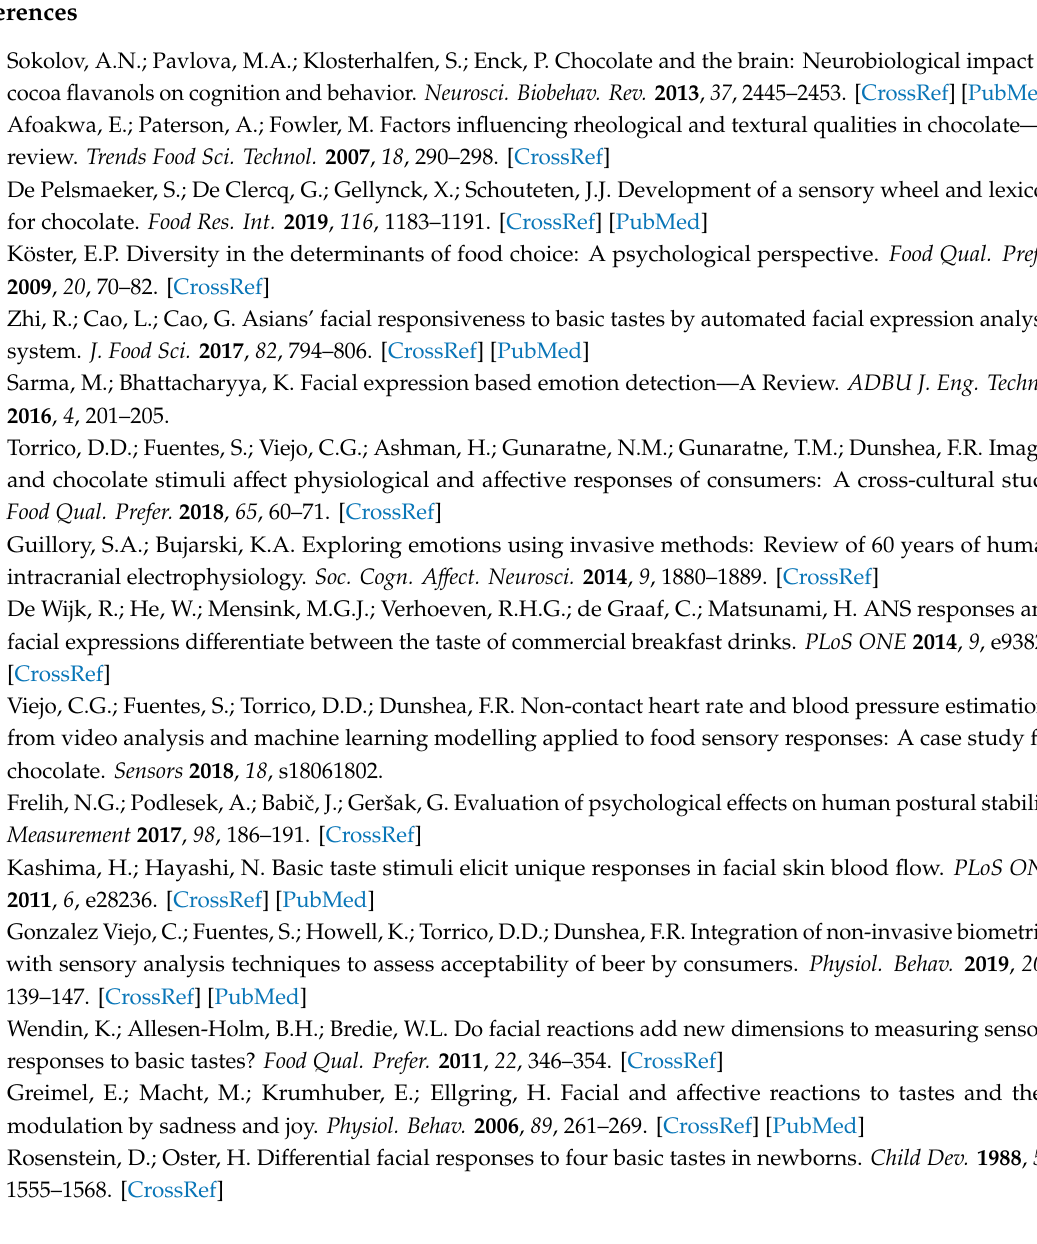
Table S1: Factor loadings from the principal component analysis for descriptors used in Figure 1. The first two principal components (PC 1 and PC 2) are